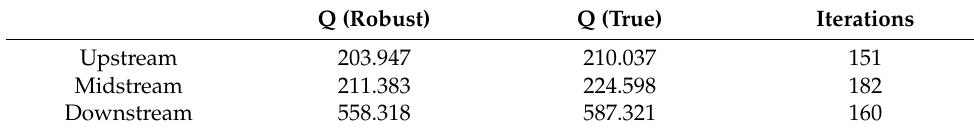
Table 6. Operation parameters in upstream, midstream, and downstream.